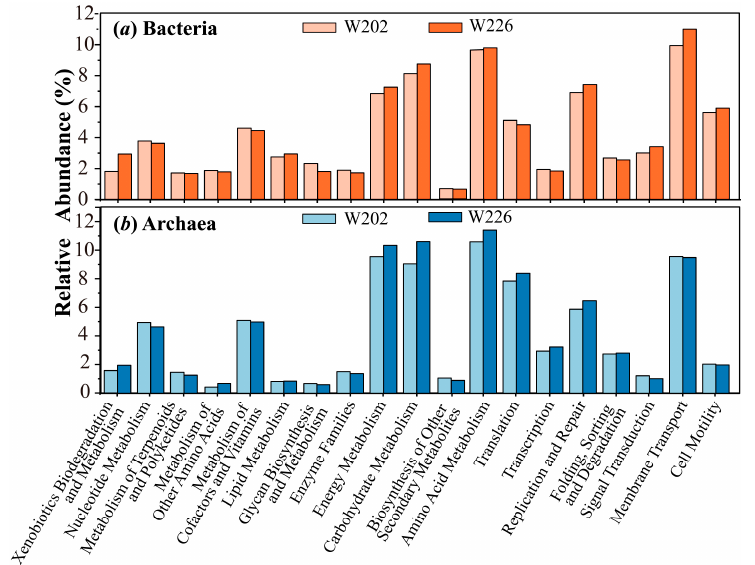
Figure 6. Variation in predicted genes from bacteria ( a ) and archaea ( b ) in production and control well at the KEGG level 2 categories by PICRUSt